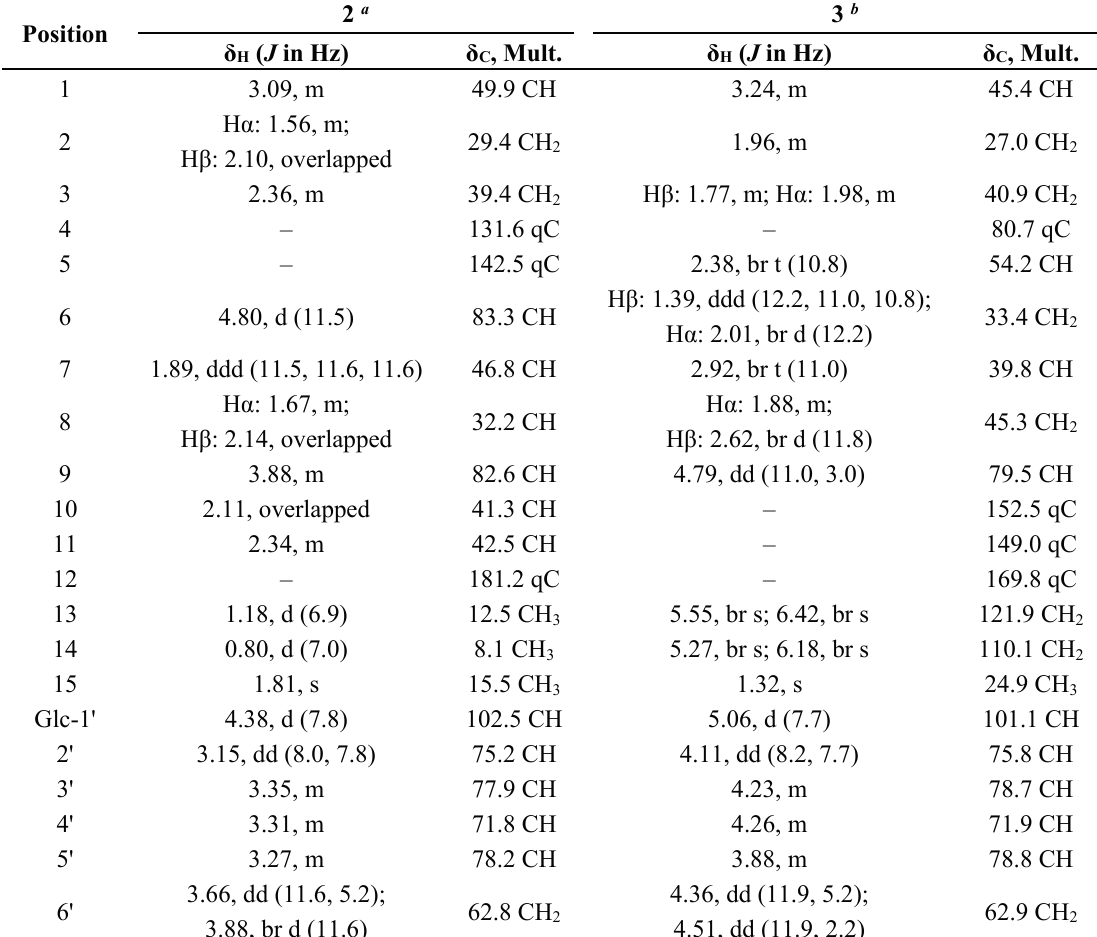
Table 2. 1 H- (400 MHz) and 13 C- (100 MHz) NMR spectral data of compounds 2 and 3 .